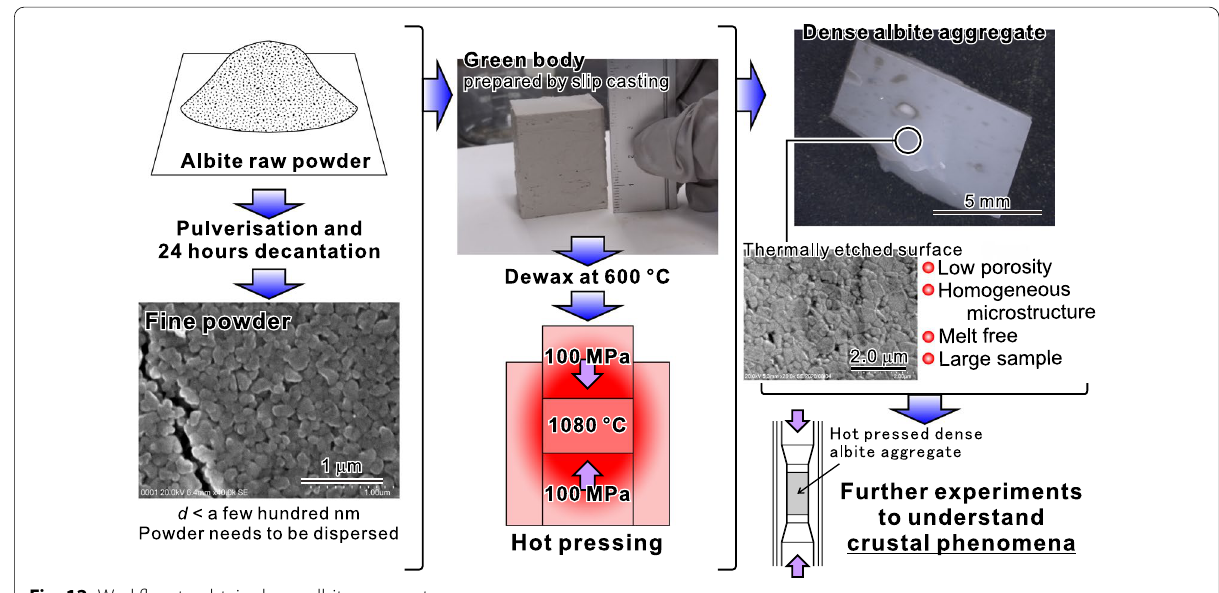
Fig. 12 Workflow to obtain dense albite